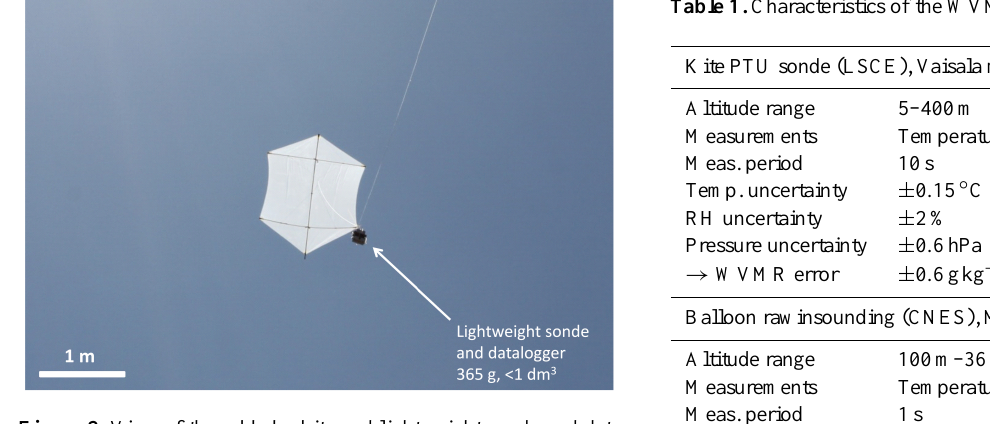
Figure 2. View of the rokkaku kite and lightweight sonde and data logger assembly used for lidar calibration.